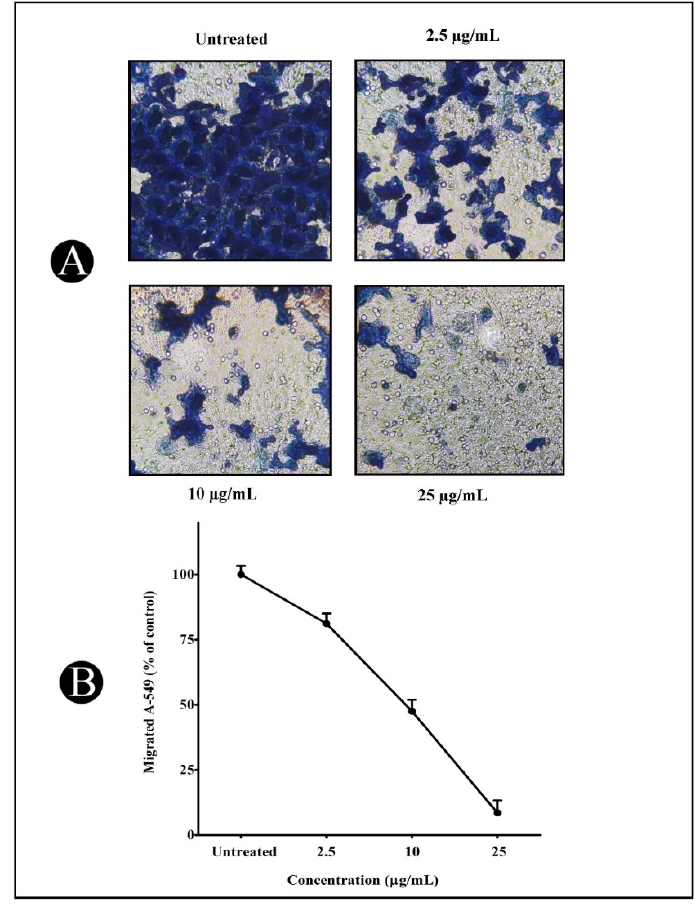
Figure 4. A549 cancer cell treatment with varied AgNP concentrations (2.5, 10 and 25 µ g/mL) at 24 h. ( A ) Cell migration was determined using Transwell ® cell culture chambers (Sigma-Aldrich, Bengaluru, India), and the average number of migrated cells was determined from three randomly selected fields. ( B ) Values are calculated as a percentage of untreated controls and presented as mean ± S.D.